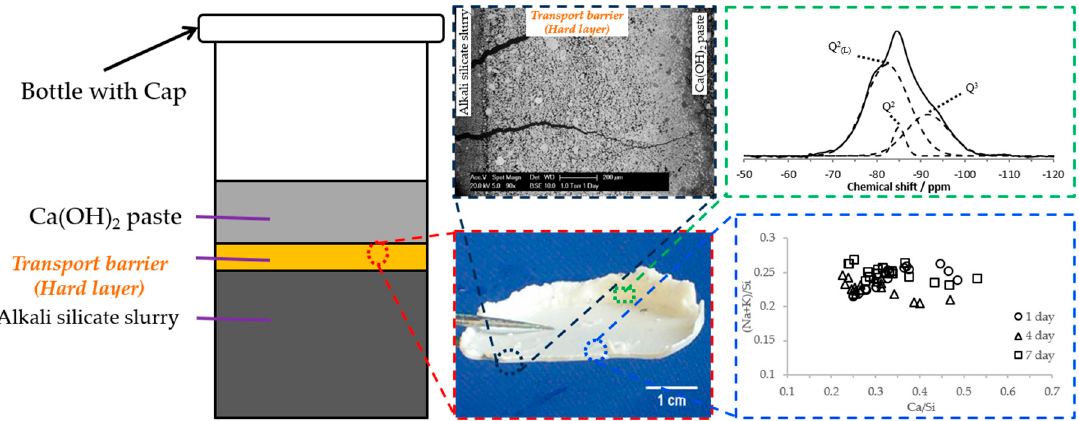
Figure 2. Graphical summary of our previous study [8].